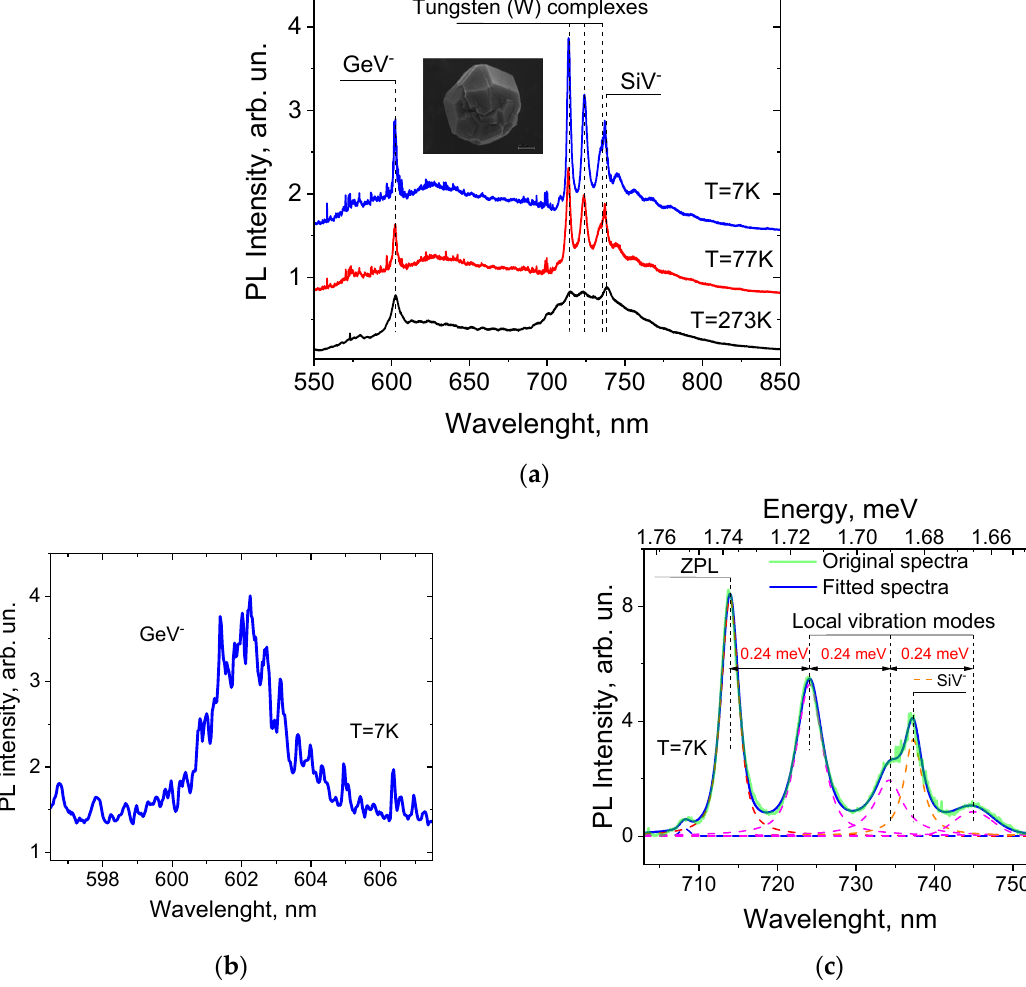
Figure 1. The PL spectra of the typical HFCVD nanodiamond under study. ( a ) Illustration of the temperature-induced evolution the PL spectra of GeV – , SiV – centers and W complexes at temperatures of 7 K, 77 K, and 273 K; inset shows SEM image of a typical HFCVD nanodiamond with diameter of ~800 nm. ( b , c ) Enlarged parts of the PL spectrum at 7 K shown in ( a ) in the regions of GeV – and W-complex emissions. The fittings of the ZPL and vibration replicas of W complexes by Gaussians are shown in panel ( c ).